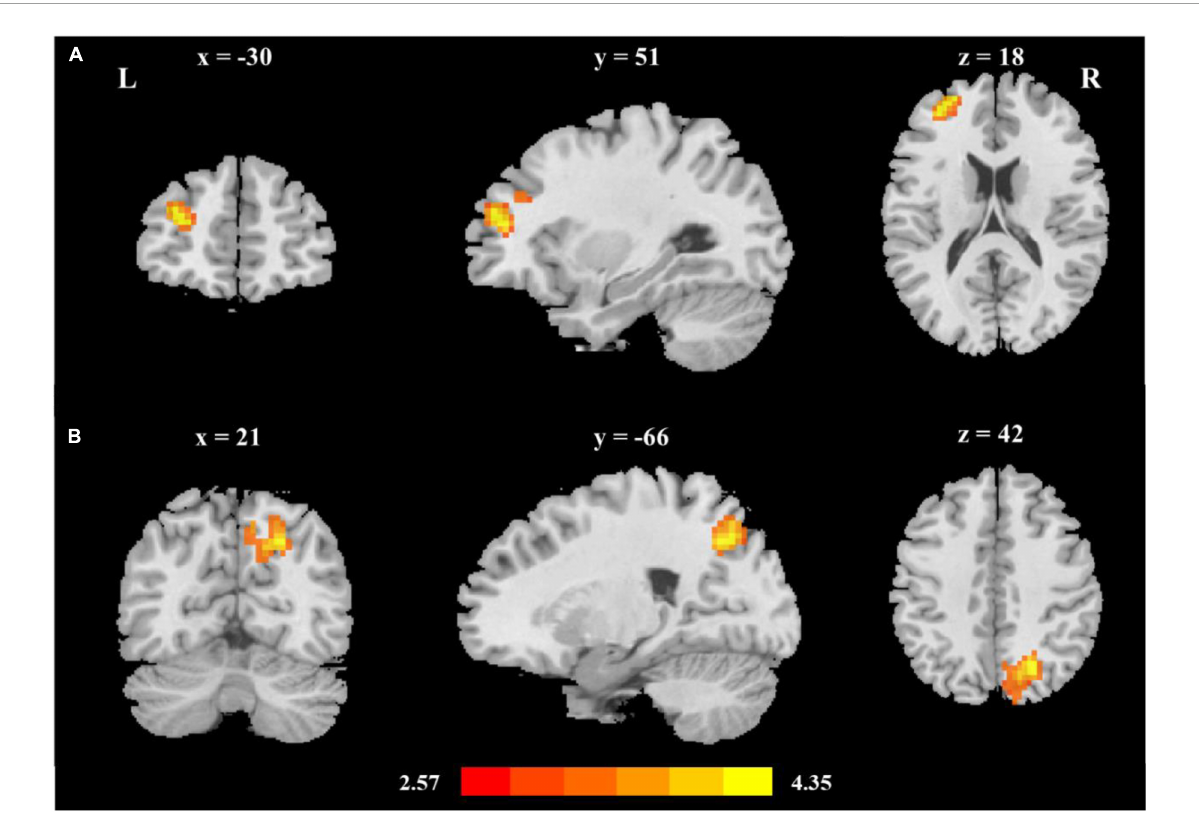
FIGURE1 The two cortico-subcortical reading pathways (A) Reading ability was related to fronto-striatal functional connectivity (left middle frontal gyrus, MNI coordinates: x = − 30, y = 51, z = 18); (B) Reading ability was related to thalamo-occipital functional connectivity (right superior occipital gyrus, MNI coordinates: x = 21, y = − 66, z = 42). Age, sex, handedness, site, household income, parental education, and head motion were used as covariates of no interest.